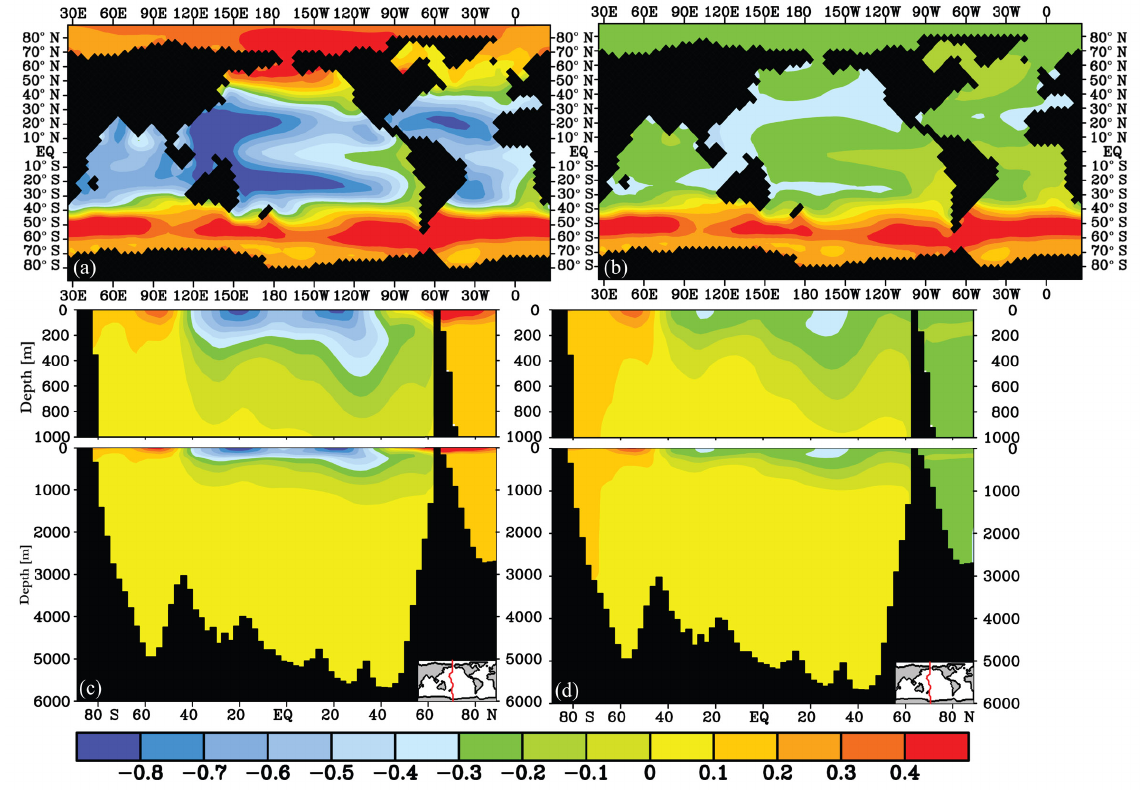
(Figs. 3a and S5): an increased air–sea gas exchange rate Table 2. Results of p CO atm (ppm) and δ 13 C atm (‰) for all sensi- 2 lowers the surface ocean δ 13 C of DIC by 0.2 ‰ to 0.9 ‰ at tivity experiments. the lower latitudes and increases surface ocean δ 13 C at high latitudes by 0.2 ‰–0.5 ‰ (Figs. 3 and 4). The direction of the response indicates whether δ 13 C diseq is positive or neg- ative, and is in line with previous studies (Schmittner et al., 2013; Galbraith et al., 2015) that show that the disequilib- rium is negative ( δ 13 C < δ 13 C eq ) at high latitudes and in low- latitude upwelling regions, and positive elsewhere. The sign of δ 13 C diseq , and thus the direction of the δ 13 C response, is understood from the difference between the natural δ 13 C dis- tribution (Fig. 1) and the δ 13 C eq , which depends on thermo- dynamic fractionation (Sect. 2). At increased gas exchange rates (i.e. closer to equilibrium), δ 13 C has to increase in cool high-latitude surface waters and has to decrease in warm low- latitude surface waters in order to get closer to equilibrium (Menviel et al., 2015; Murnane and Sarmiento, 2000). The net effect of a slower gas exchange rate on surface ocean δ 13 C is less pronounced than the effect of an increased gas exchange rate (Figs. S5, 3). The smaller effects seen for slow gas exchange indicate that the control model ocean is a “slow ocean”, i.e. closer to (very) slow gas exchange than to ther- modynamic equilibrium (infinitely fast gas